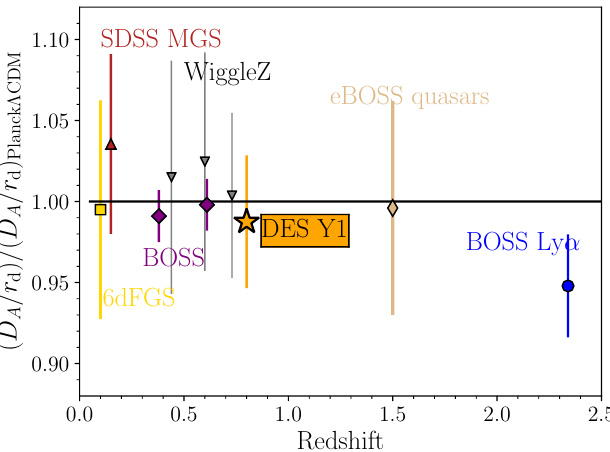
Figure 8. Measurement of the angular diameter distance from DES, compared to the Planck prediction and other measurements. From Reference